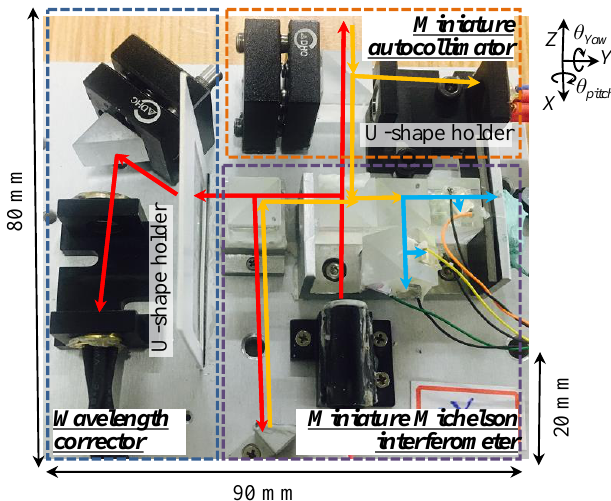
Figure 5. Photo of the constructed 3DOFLM system.